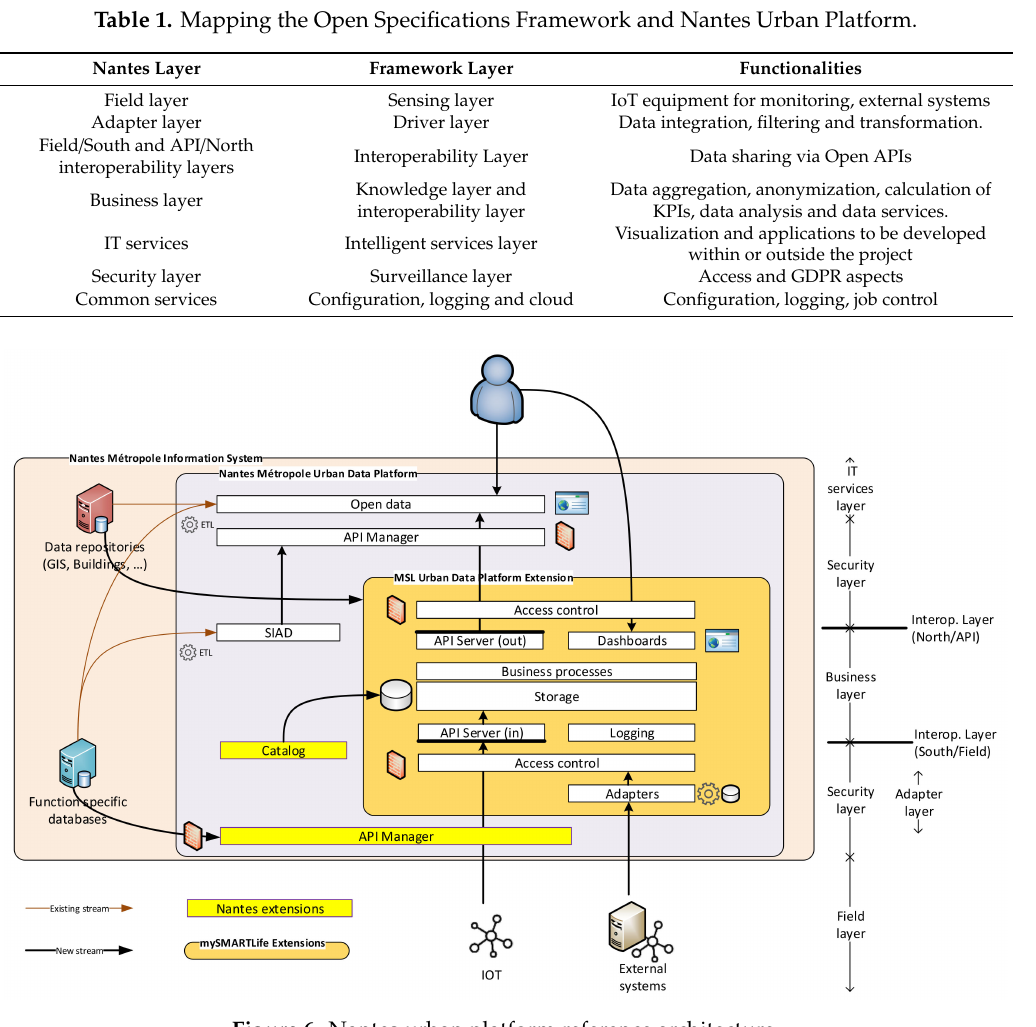
Figure 6. Nantes urban platform reference